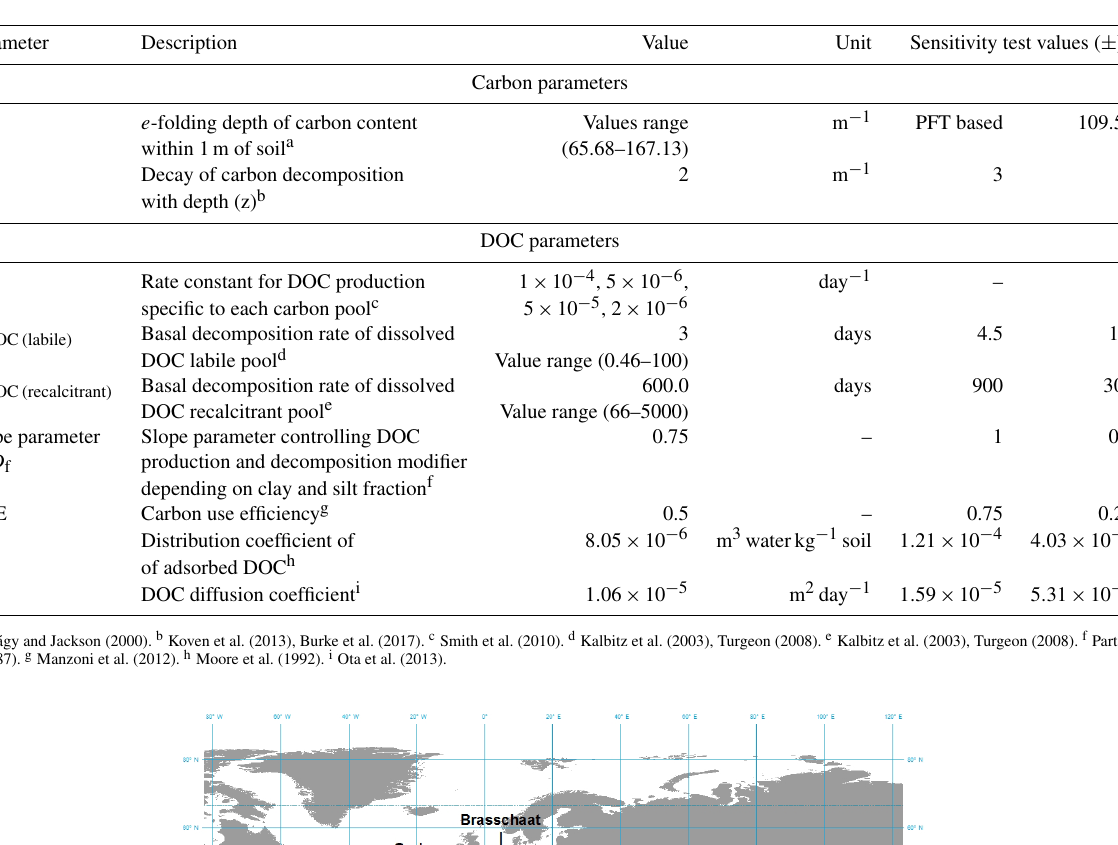
Table 1. DOC-relevant parameters in the JULES-DOCM model.